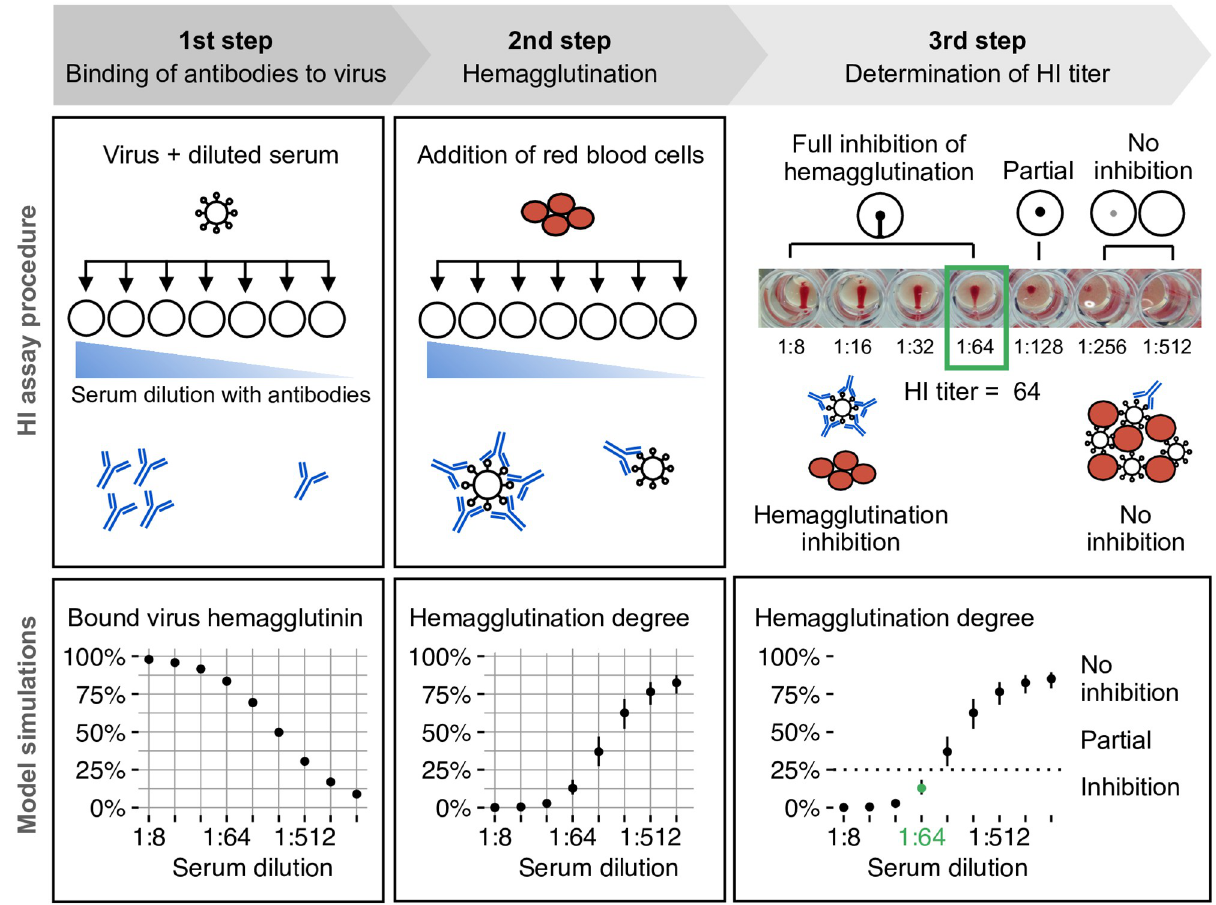
Fig 1. Overview of the hemagglutination inhibition (HI) assay (top) and illustrative simulation results (bottom). First step: patient serum is serially diluted and incubated with a constant amount of influenza virus. The model computes the amount of antibody-bound viral hemagglutinin (HA) for each serum dilution. Second step: red blood cells (RBCs) are added to each dilution and virus particles with free HA binding sites cross-link RBCs to cell aggregates. The model predicts a switch-like increase in agglutinated RBCs with decreasing antibody concentration. Third step: the plate is tilted by 90 degrees to detect full hemagglutination inhibition. If none/few RBCs are agglutinated, sedimented RBCs flow down to the rim. By definition, those wells show full hemagglutination inhibition. The reciprocal of the maximal inhibitory dilution is the HI titer. We classify our simulation results into inhibition and no inhibition by setting a threshold at 25% hemagglutination. Simulation results show median and interquartile range indicating the uncertainty due to experimental conditions (RBC concentration, virus concentration, readout time) and model parameters (summarized in Table 1) for an IgG serum concentration of 25 nM (4 μ g/mL) and K app ¼ 0 : 1 nM . D